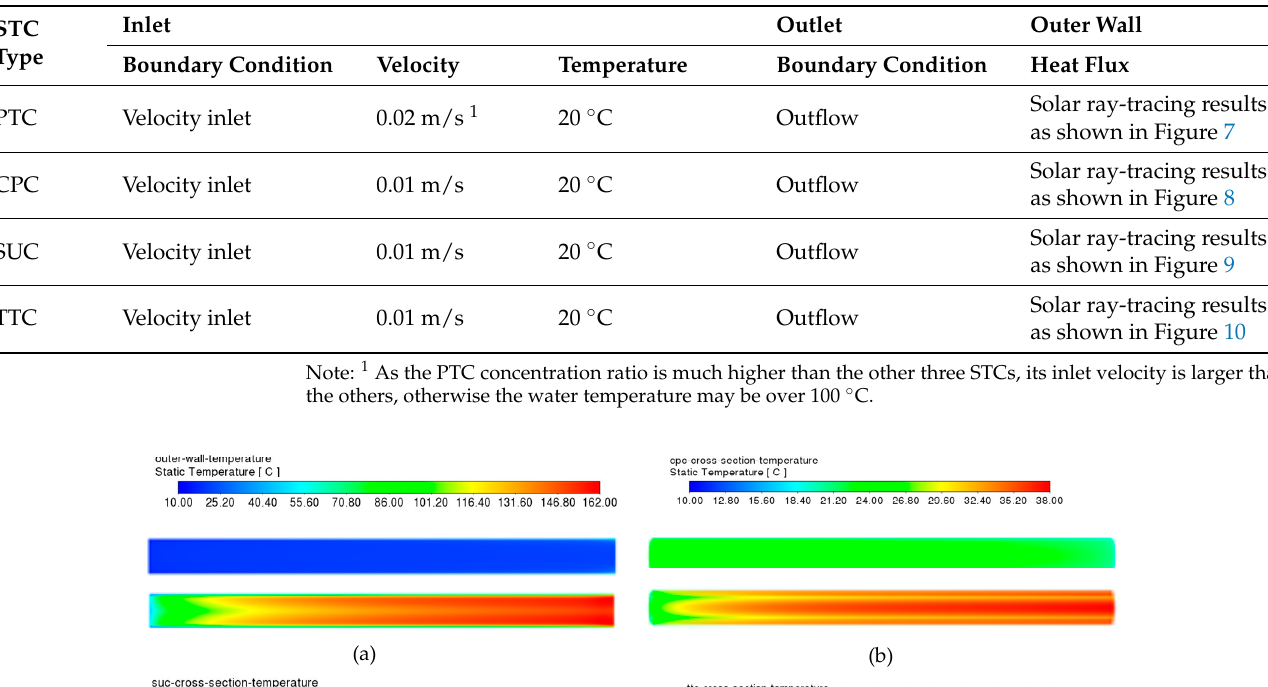
Table 3. Parameters in thermal performance system of the four STCs.